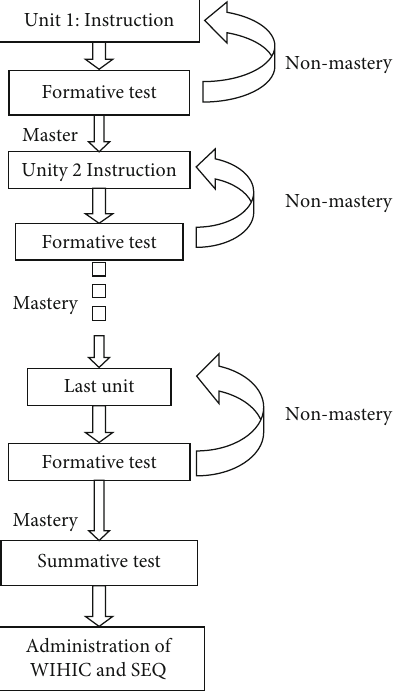
Figure 1: Diagrammatic fl ow of the teaching procedures in CML